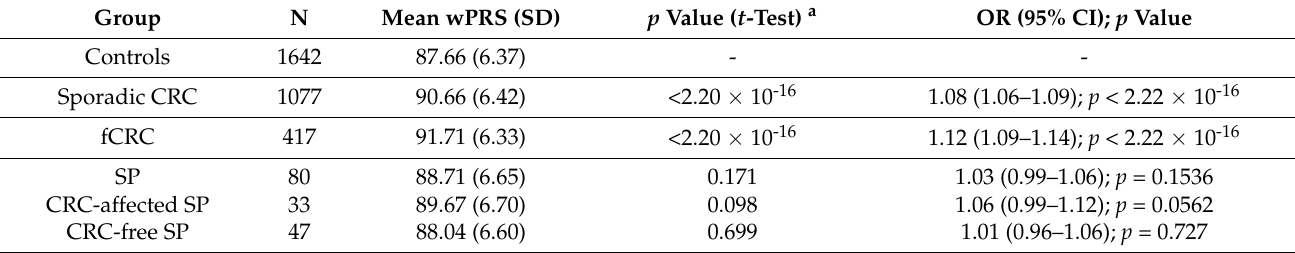
a Comparison of the mean wPRS value of each group vs. the control group. Abbreviations: CI, confidence interval; N, number of patients or controls; OR, odds ratio; wPRS, weighted PRS; CRC, colorectal cancer; fCRC, familial/early-onset colorectal cancer; SP, serrated polyposis; SD, standard deviation.